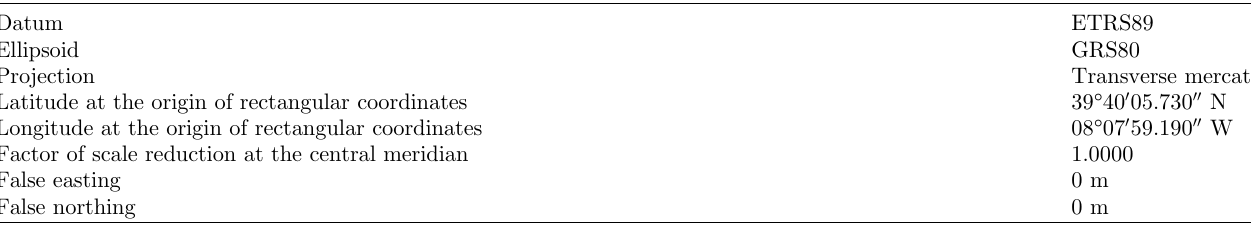
Table A-3. Parameters of PT-TM06 (for mainland Portugal).